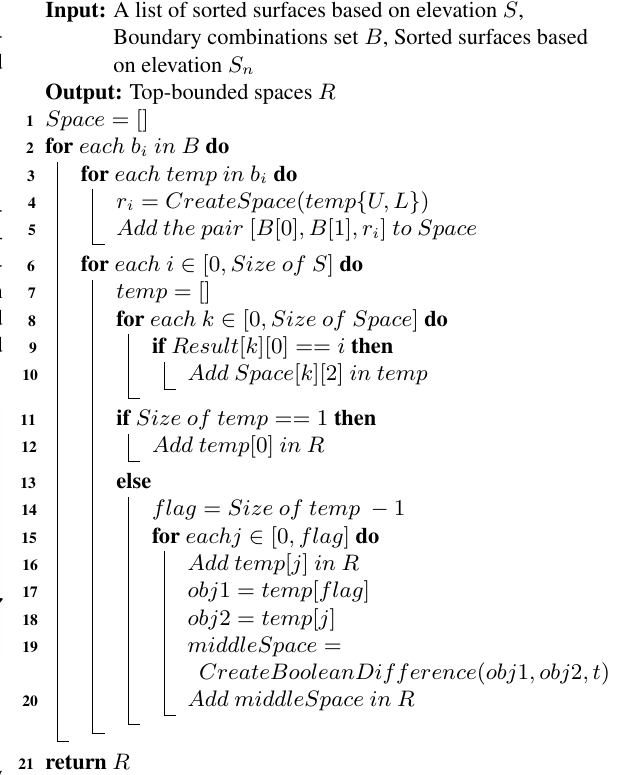
Algorithm 2: The process of creating and trimming top- bounded spaces based on their upper and lower